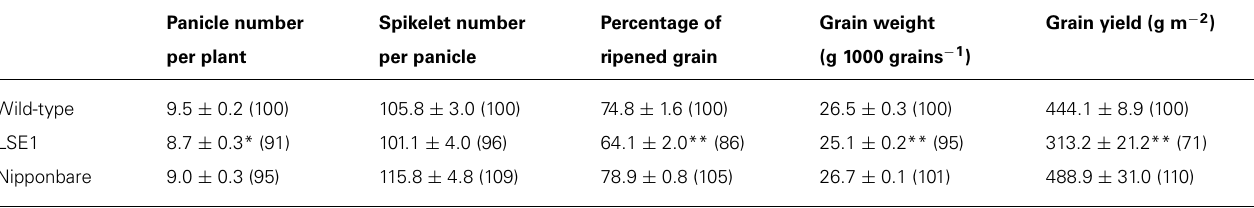
Table 2 |Yield components and grain yield of LSE1, wild-type and the original cultivar Nipponbare grown under field